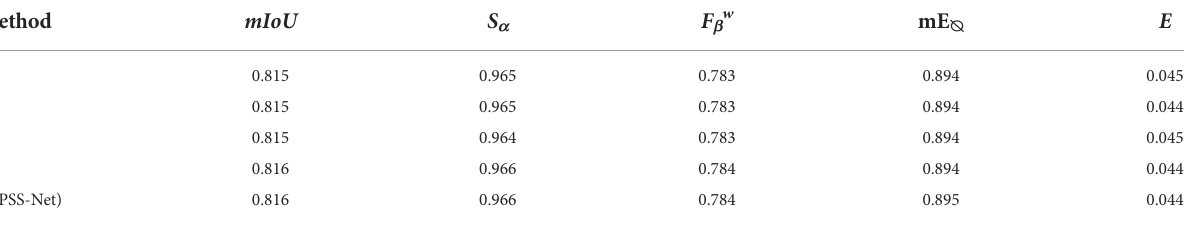
TABLE 5 Comparative accuracies of testing with feature maps fusion using addition and average, multiplication, addition, and using attention (proposed method) in MAS3K dataset (case 2). Method